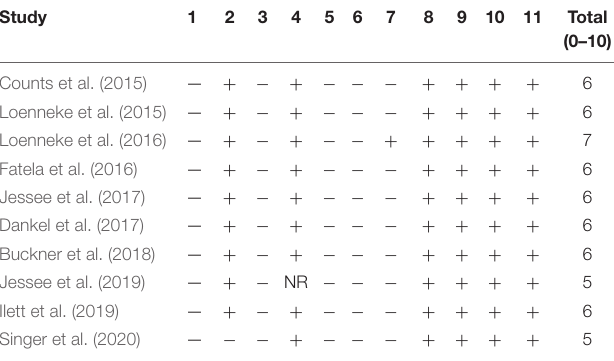
TABLE 1 | Methodological quality of the included